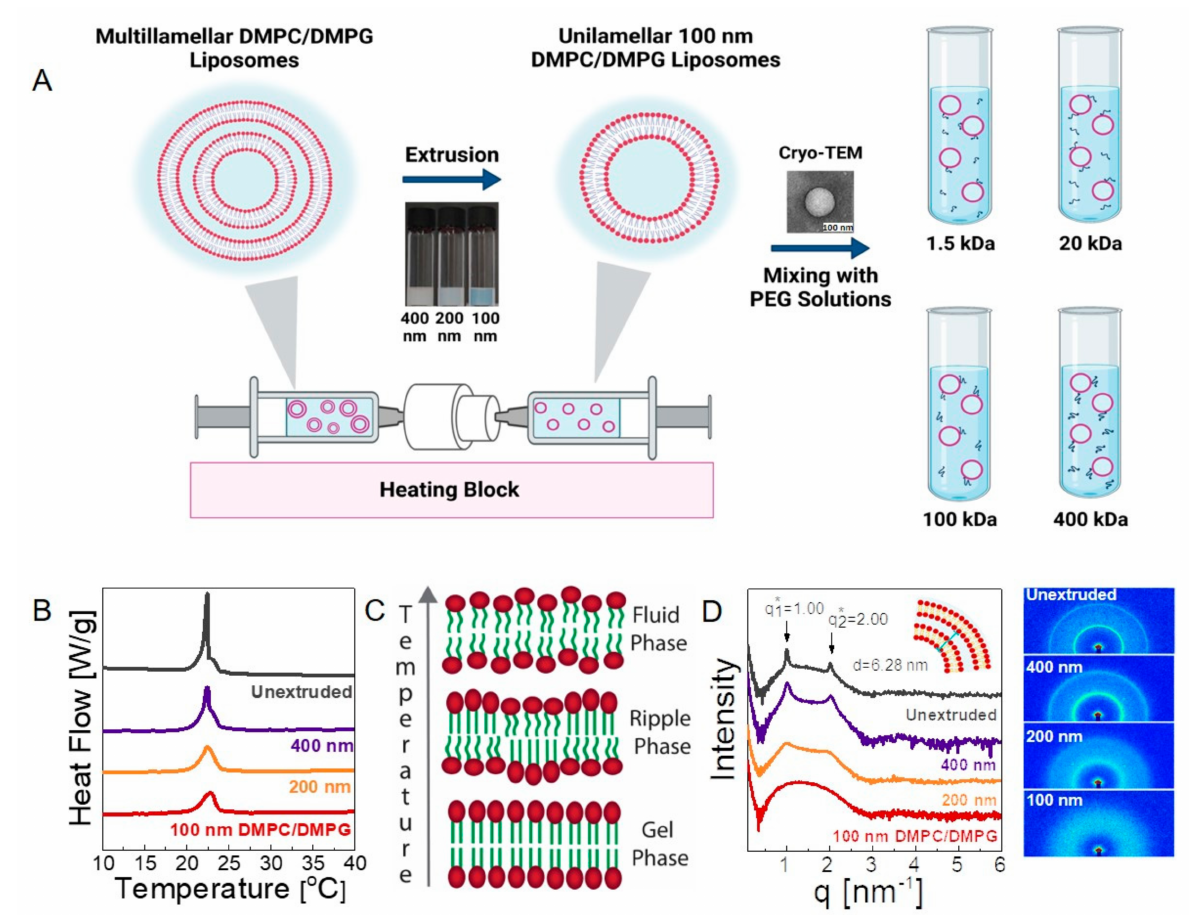
Figure 1. ( A ) Schematic image of the system; 20 mg/mL DMPC/DMPG solution is extruded through 400 nm (15 × ), 200 nm (15 × ), and 100 nm (41 × ) membranes, respectively. Multilamellar liposomes forming spontaneously in solution are represented on the left-hand side before extrusion. Following extrusion, unilamellar and 100 nm liposomes are obtained. The liposome solutions are then mixed with solutions of PEG with four different molecular weights, specifically 1.5, 20, 100, and 400 kDa. ( B ) DSC traces of 20 mg/mL unextruded, 400 nm, 200 nm, and 100 nm lipid solutions. ( C ) Phase transition of lipids from gel phase to fluid phase with increasing temperature. ( D ) SAXS analysis of unextruded, extruded 400 nm, 200 nm, and 100 nm liposomes and raw detector data. Two peaks at q ∗ = 1.00 and q ∗ = 2.00, corresponding to Bragg spacing of 6.28 nm, were obtained. All measurements 2 1 in B and D were repeated three times to ensure reproducibility of the